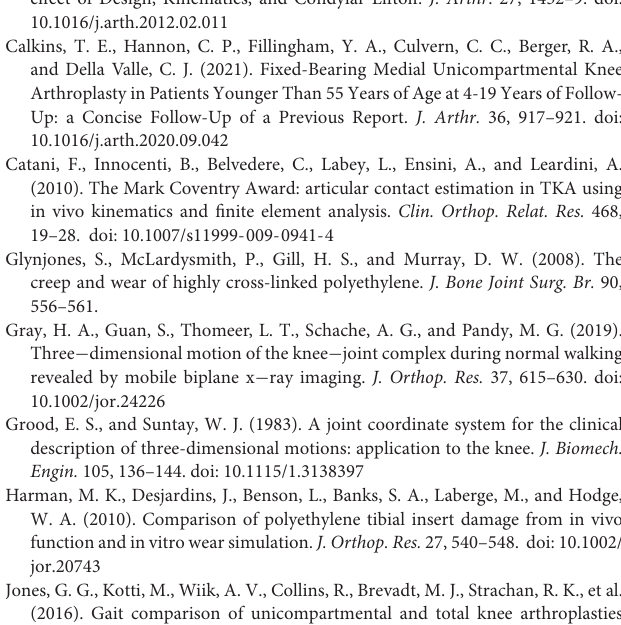
Supplementary Figure 1 | Average and standard deviation of 6-DOF kinematics of operated knee during stance phase of gait for unilateral FB UKA patients. (A–C) knee flexion/extension (F/E), tibial internal/external rotation (IR/ER), tibial adduction/abduction (ADD/ABD); (D–F) femoral anterior/posterior translation (A/P), proximal/distal translation (P/D) and medial/lateral translation (M/L). The rotations reported here described the tibial rotations relative to the femur. The translations represented the femoral motions relative to the tibia. Supplementary Figure 2 | Average and standard deviation of 6-DOF kinematics of operated knee during single-leg deep lunge for unilateral FB UKA patients. (A–C) knee flexion/extension (F/E), tibial internal/external rotation (IR/ER), tibial adduction/abduction (ADD/ABD); (D–F) femoral anterior/posterior translation (A/P), proximal/distal translation (P/D) and medial/lateral translation (M/L). The rotations reported here described the tibial rotations relative to the femur. The translations represented the femoral motions relative to the tibia. Supplementary Figure 3 | Average and standard deviation of 6-DOF kinematics of operated knee during sit-to-stand motion for unilateral FB UKA patients. (A–C) knee flexion/extension (F/E), tibial internal/external rotation (IR/ER), tibial adduction/abduction (ADD/ABD); (D–F) femoral anterior/posterior translation (A/P), proximal/distal translation (P/D) and medial/lateral translation (M/L). The rotations reported here described the tibial rotations relative to the femur. The translations represented the femoral motions relative to the